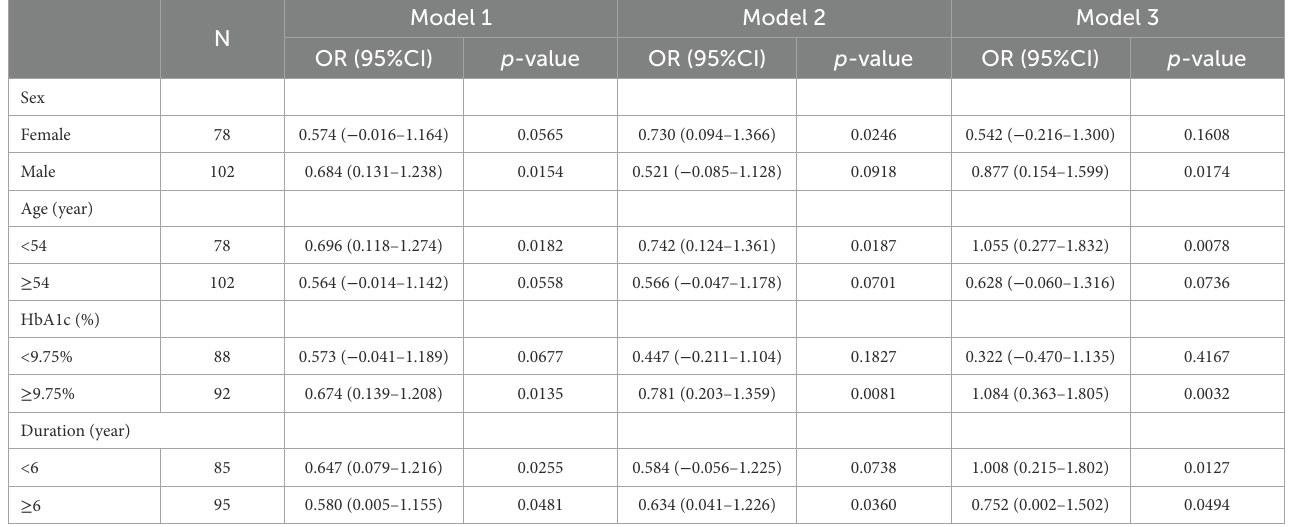
TABLE 5 Subgroup analysis of odds ratios of the TyG index with HFA-PEFF score in T2DM.